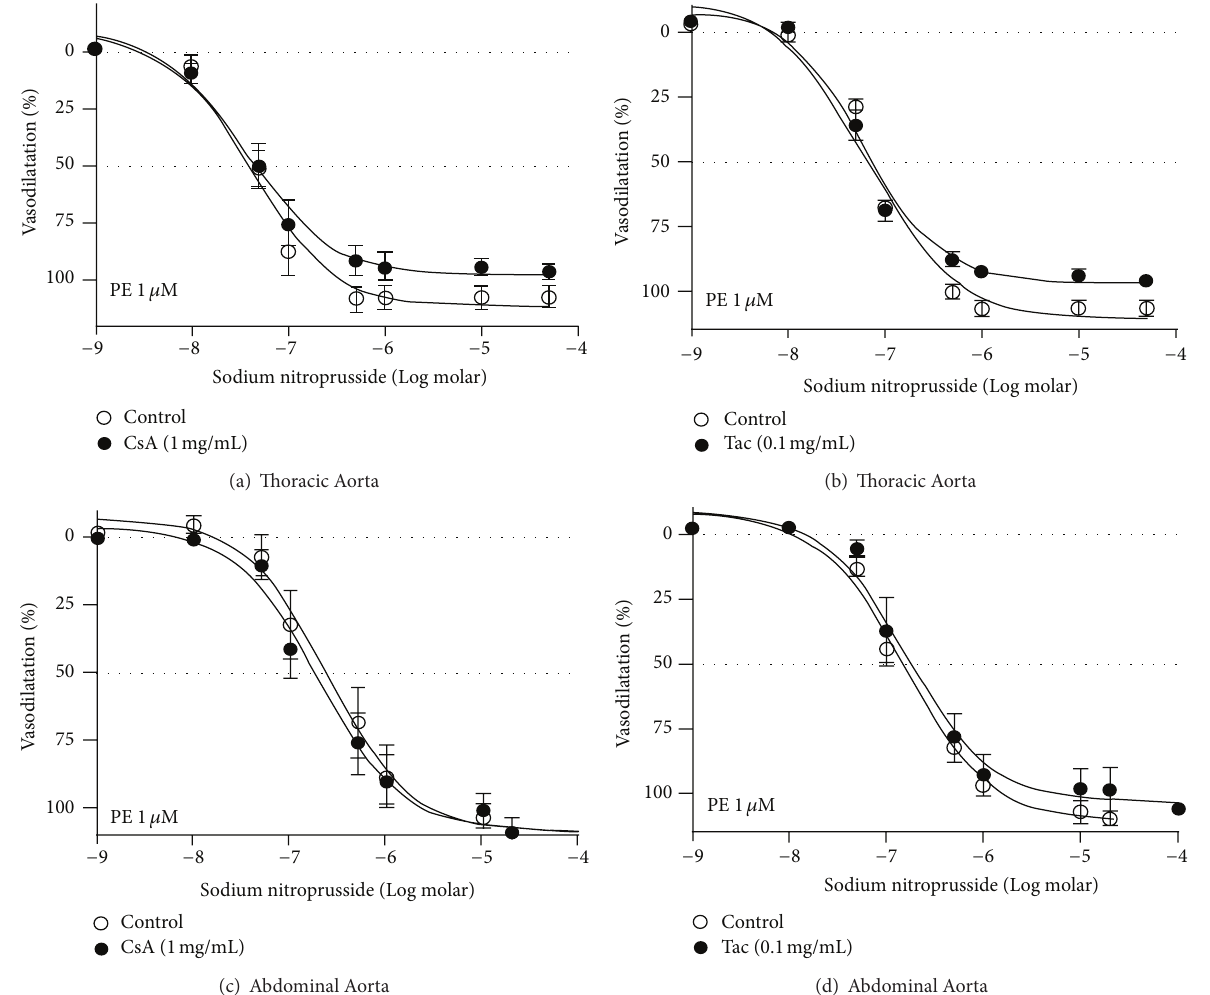
Figure 2: The panel compares the CRC to sodium nitroprusside (SNP) determined in PE (1 𝜇 M)-constricted thoracic ((a) and (b) panels) and abdominal ((c) and (d) panels) aortic rings in the presence or absence of cyclosporine (CsA—1mg/mL) and tacrolimus (Tac—0.1mg/mL). Each data point is mean ± SEM value obtained from aortic rings isolated from 6